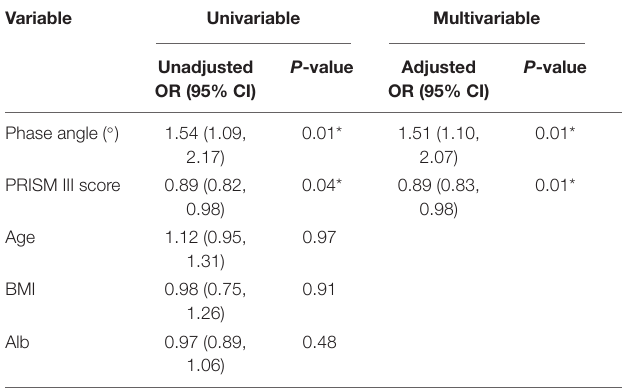
TABLE 4 | Logistic regression multivariate analysis of determinants of 90-mortality.